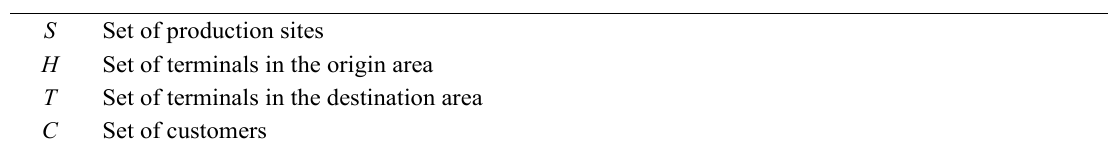
Notations used in the mathematical